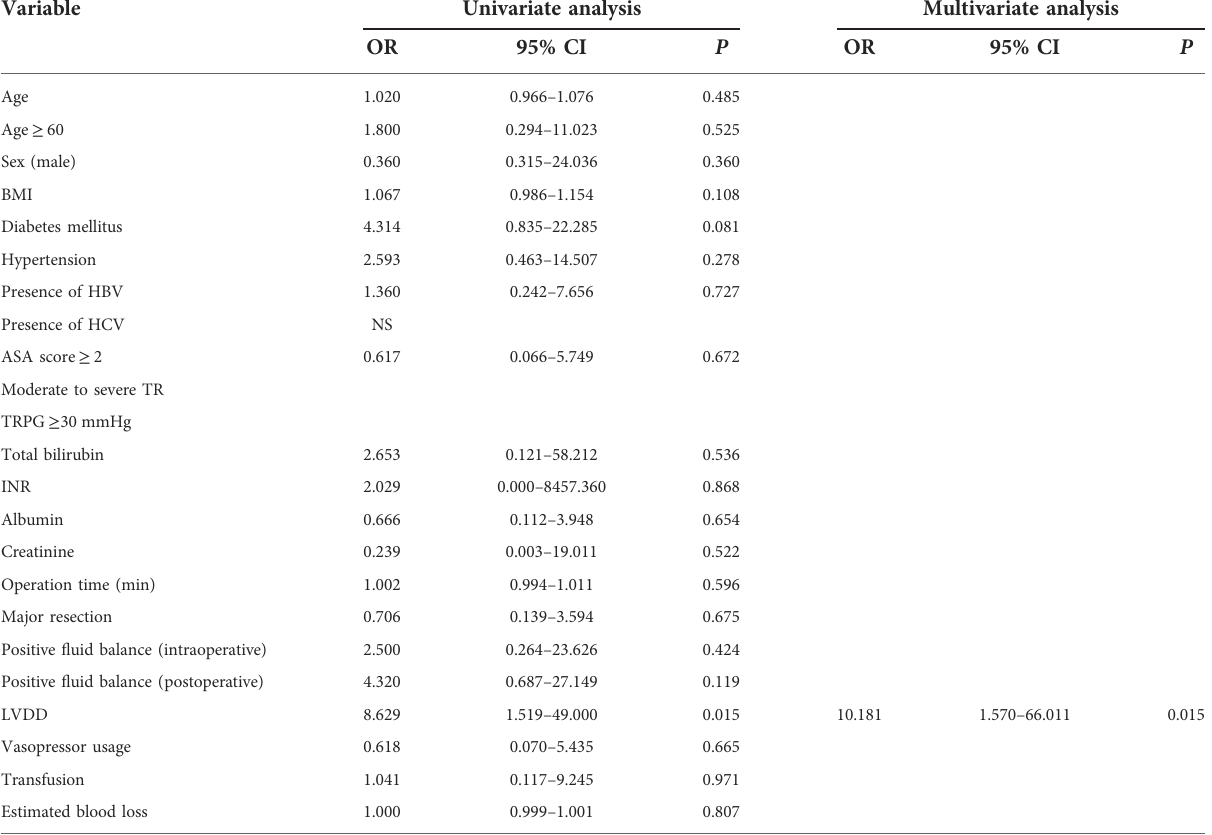
TABLE 3 Analysis of risk factors for postoperative acute kidney injury.